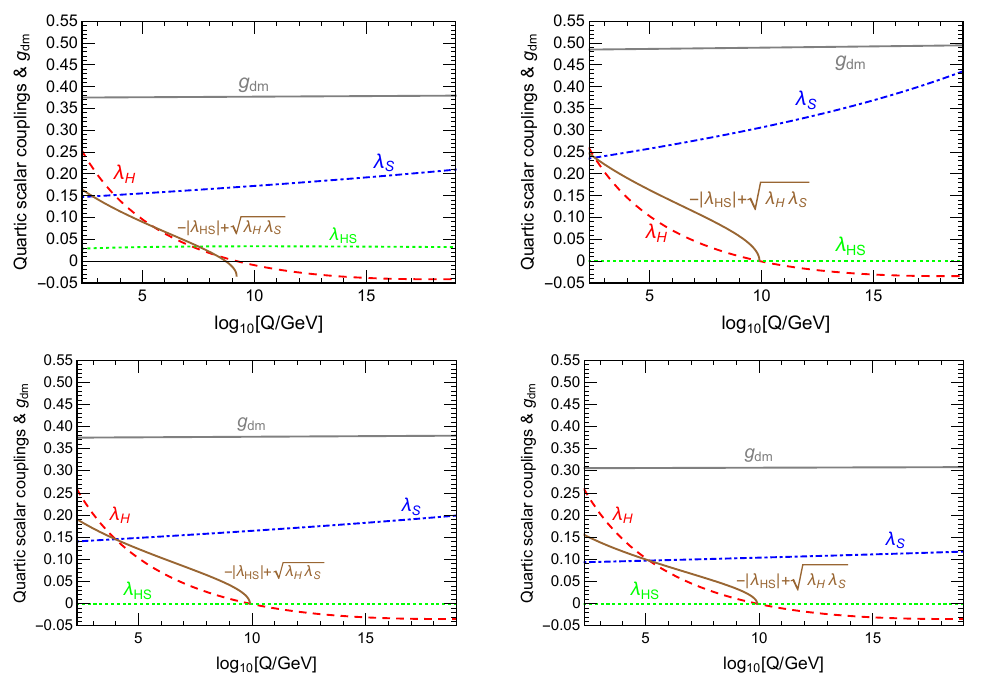
Figure 8 . Running of quartic scalar couplings and g dm , as functions of the renormalization scale Q . Here at scale Q = m t (the top quark mass), we use m X = m S = 86 GeV, and ( g dm ; (cid:11) ) = (0.375, 0.2), (0.375, (cid:24) 0), (0.485, (cid:24) 0), and (0.306, (cid:24) 0) for the upper left, lower left, upper right, and lower right panels, respectively. In the limit of m S ! m X and (cid:11) ! 0, the scale-dependence of the quartic scalar couplings, insensitive to the values of m X and m S , depends only on the initial value of g dm , for which, as the reference value, we have used the central values of the GC excess (cid:12)ts for the case m S = 0 : 999 m X shown in (cid:12)gure